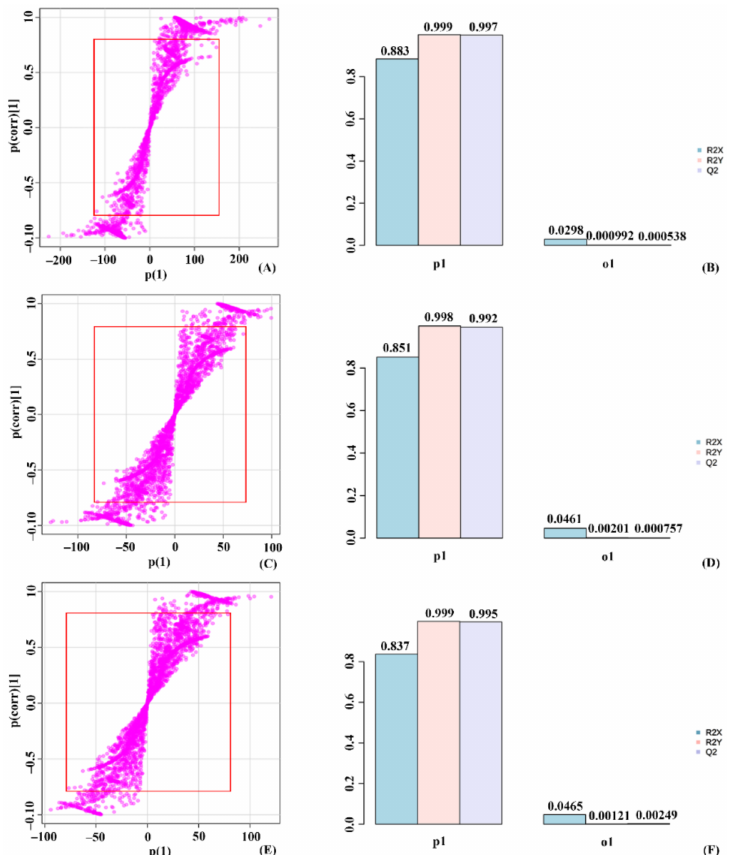
Figure 8. OPLS-DA plot grouping 50 mM stressed plants based on significantly expressed metabolites. ( A ) S-plot for control vs. treated_4, ( B ) mdsl plot with T-score and orthogonal T-score for control vs. treated_4, ( C ) S-plot for treated_4 vs. treated_5, ( D ) mdsl plot with T-score and orthogonal T-score for treated_4 vs. treated_5, ( E ) S-plot for treated_5 vs. treated_6, ( F ) mdsl plot with T-score and orthogonal T-score for treated_5 vs.